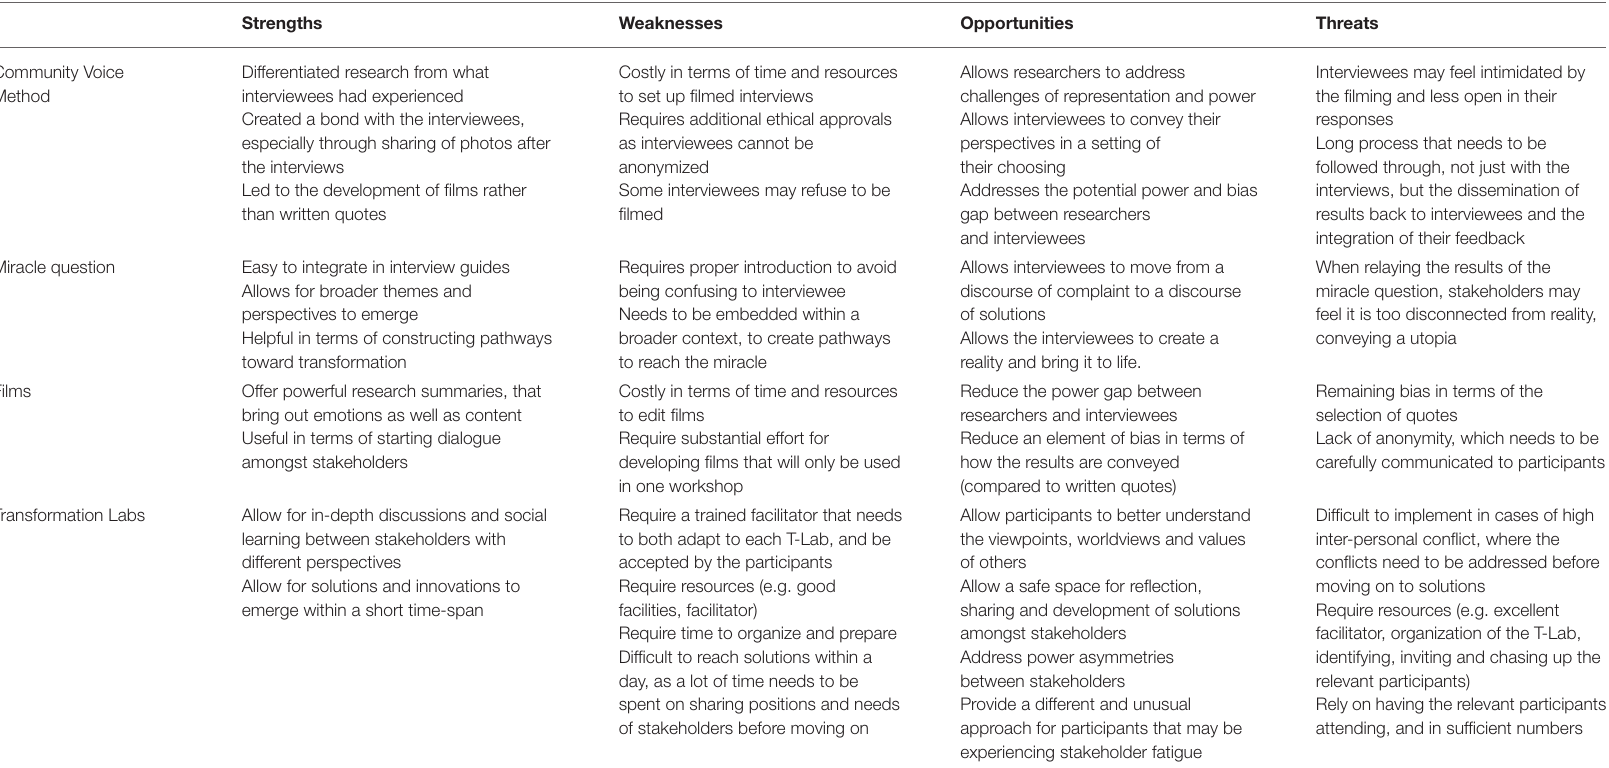
TABLE 2 | SWOT analysis of the four transdisciplinary techniques used in the context of transformative change and conflicts.